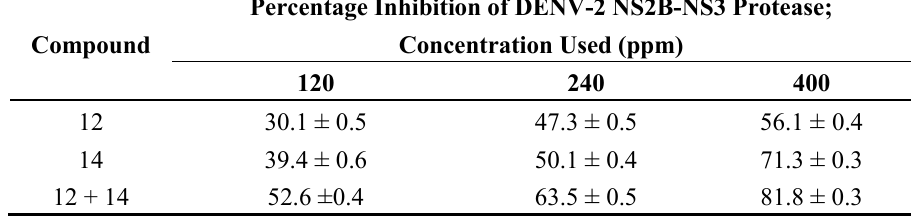
Table 4. Percentage inhibition of DENV-2 NS2B-NS3 virus protease cleavage a of compounds and 12 and 14 .